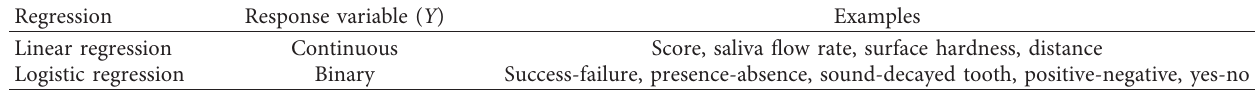
Table 1: Comparison between linear regression and logistic